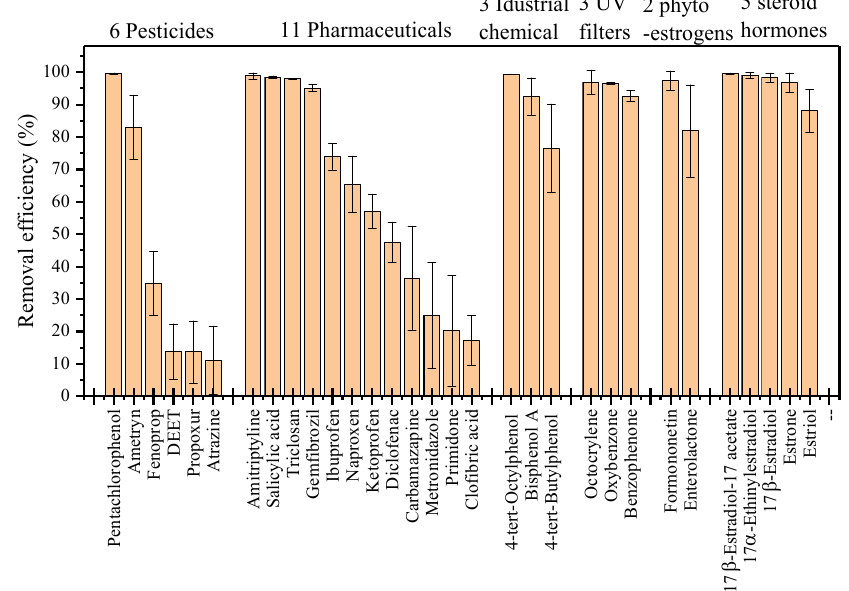
Figure 6. Removal efficiency of 31 emerging contaminants by enzymatic membrane bioreactor with crude enzyme extract from Pleurotus ostreatus. The data were the average and standard deviation of six samples. The samples were collected at 22, 44 and 88 h of the EMR operation.